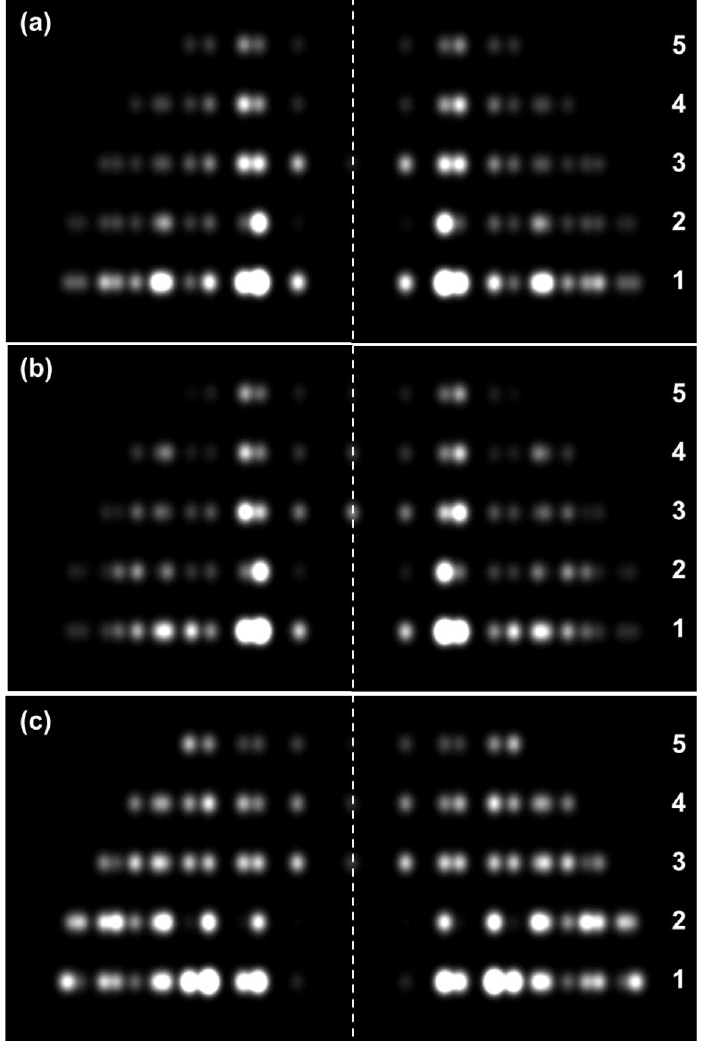
Figure 5. ( a ) Simulated X-ray diffraction pattern using the observed corrected intensities from bony fish muscle (cf. Figure 2a). ( b ) Calculated diffraction pattern using the myosin filament structure (Figure 3a) from Hudson et al. [10] that is the best fit to ( a ); R-Factor 7.9%. ( c ) The calculated X-ray pattern if the human heart muscle myosin filaments with the interacting head motif (AL-Khayat et al. [26]) are put into the fish muscle unit cell instead of the structure from Hudson et al.; lowest R-Factor = 54%. Inclusion of myosin S2 in the calculation in ( c ) makes the fit slightly less good (see Figure 4). All patterns were scaled to have the same total intensity. Introduction of a small lateral disorder factor (2D temperature factor) slightly improved the R-factor in (c) (with S-2) to 32% with a root mean squared lateral displacement of the myosin filament from its ideal lattice point of 22 Å .